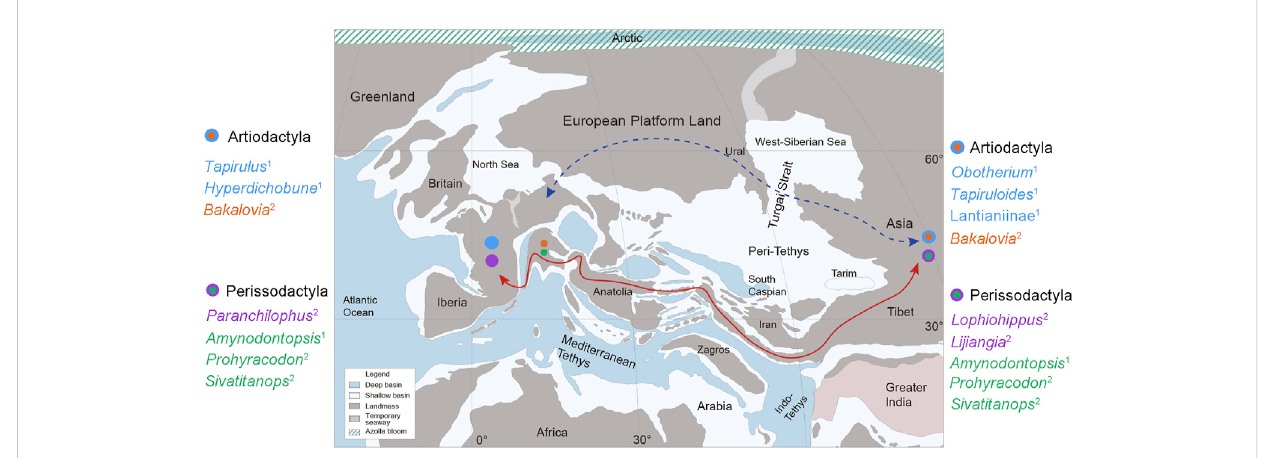
FIGURE 10 Paleogeography of Tethys region during the middle Eocene and probable dispersal routines between Asian and European mammal groups. The superscript numbers 1 and 2 indicate the early middle Eocene and late middle Eocene taxa, respectively. (The paleogeographic map was modi fi ed from Palcu and Krijgsman, 2022, fi g. 8, with permission from W.